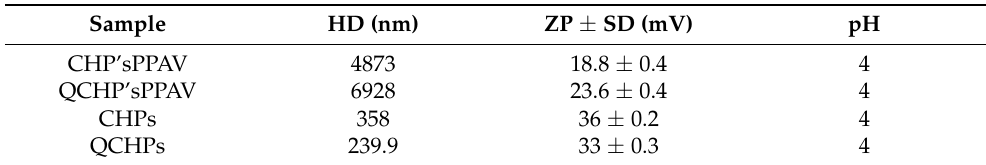
Table 4. Hydrodynamic diameter (HD) and zeta potential (ZP) with standard deviation (SD) of different formulations.